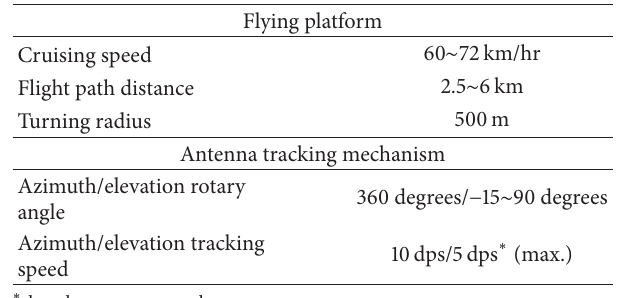
Table 3: Antenna/transceiver specification of ground tracking unit. Antenna polarization